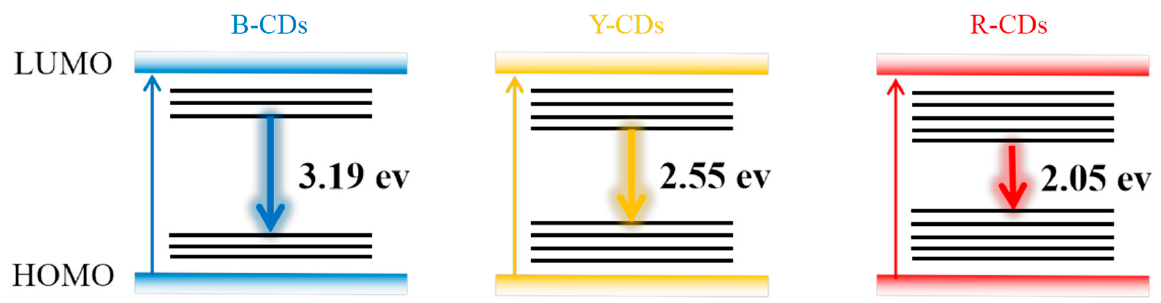
Figure 6. Dependence of the HOMO and LUMO energy levels of MCDs.